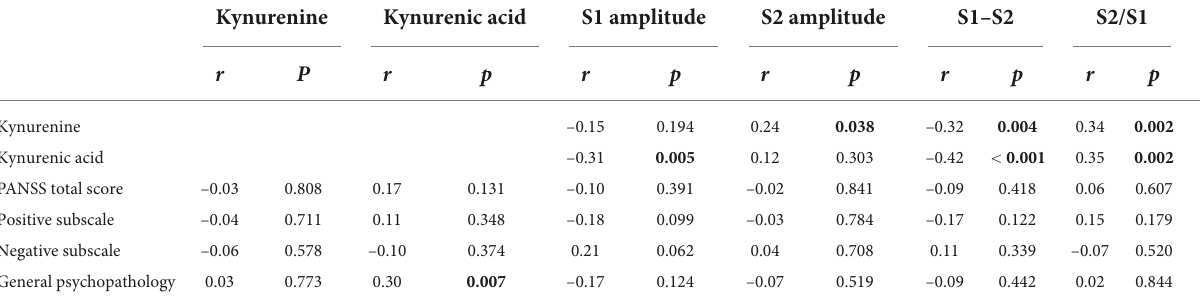
TABLE 3 Correlations between P50 parameters, the serum levels of KYN and KYNA as well as the severity of symptoms in the patient